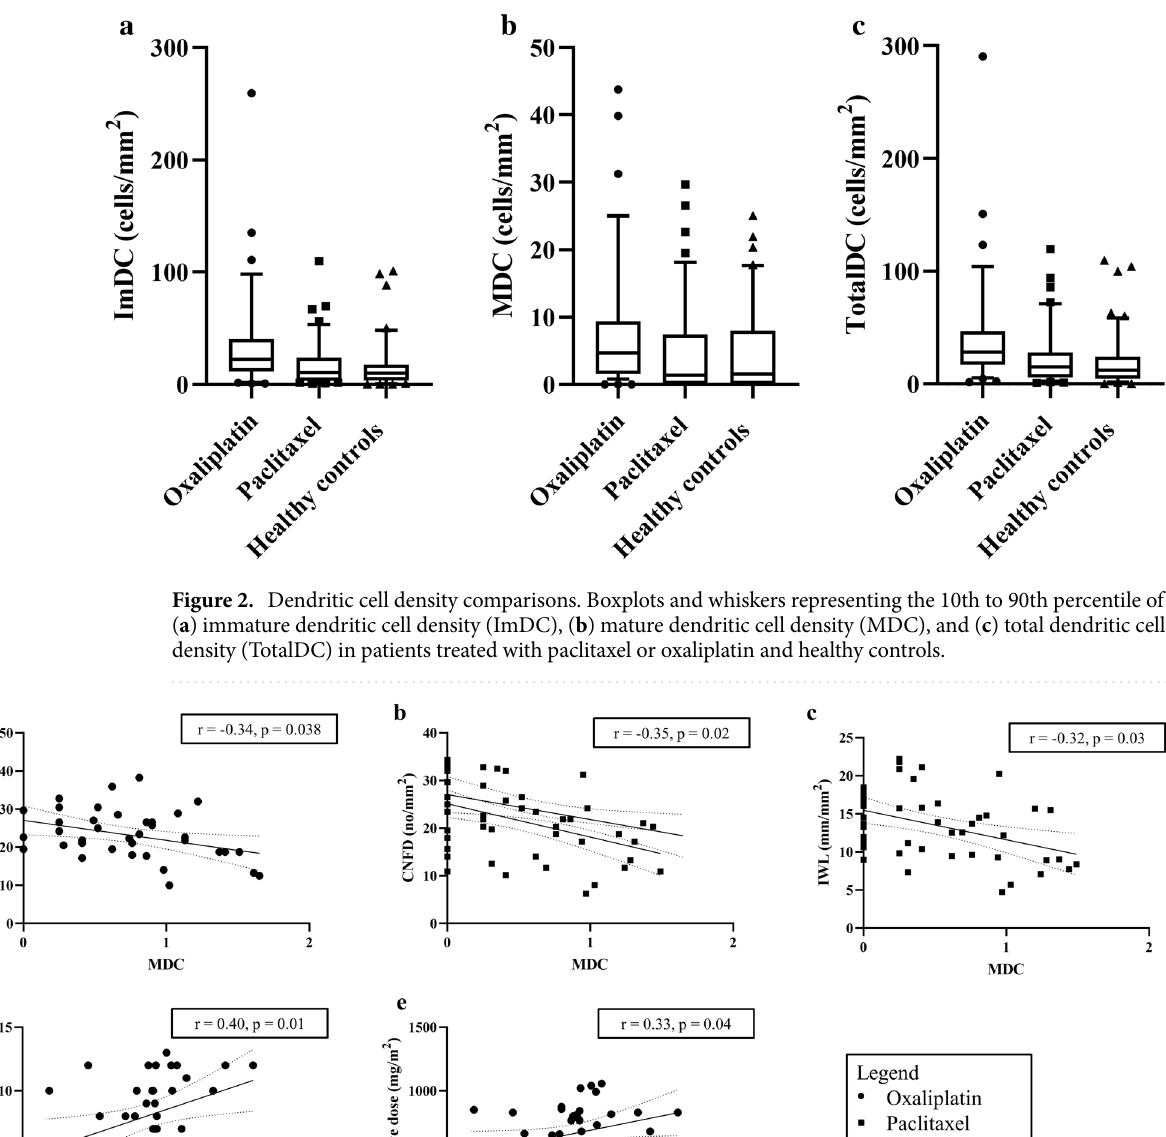
Correlation analysis showed that higher MDC was associated with CNFD loss in the oxaliplatin group (r = 0.34, p = 0.038; Fig. 3a, Table 3). Higher MDC were also associated with loss of CNFD and IWL in paclitaxel